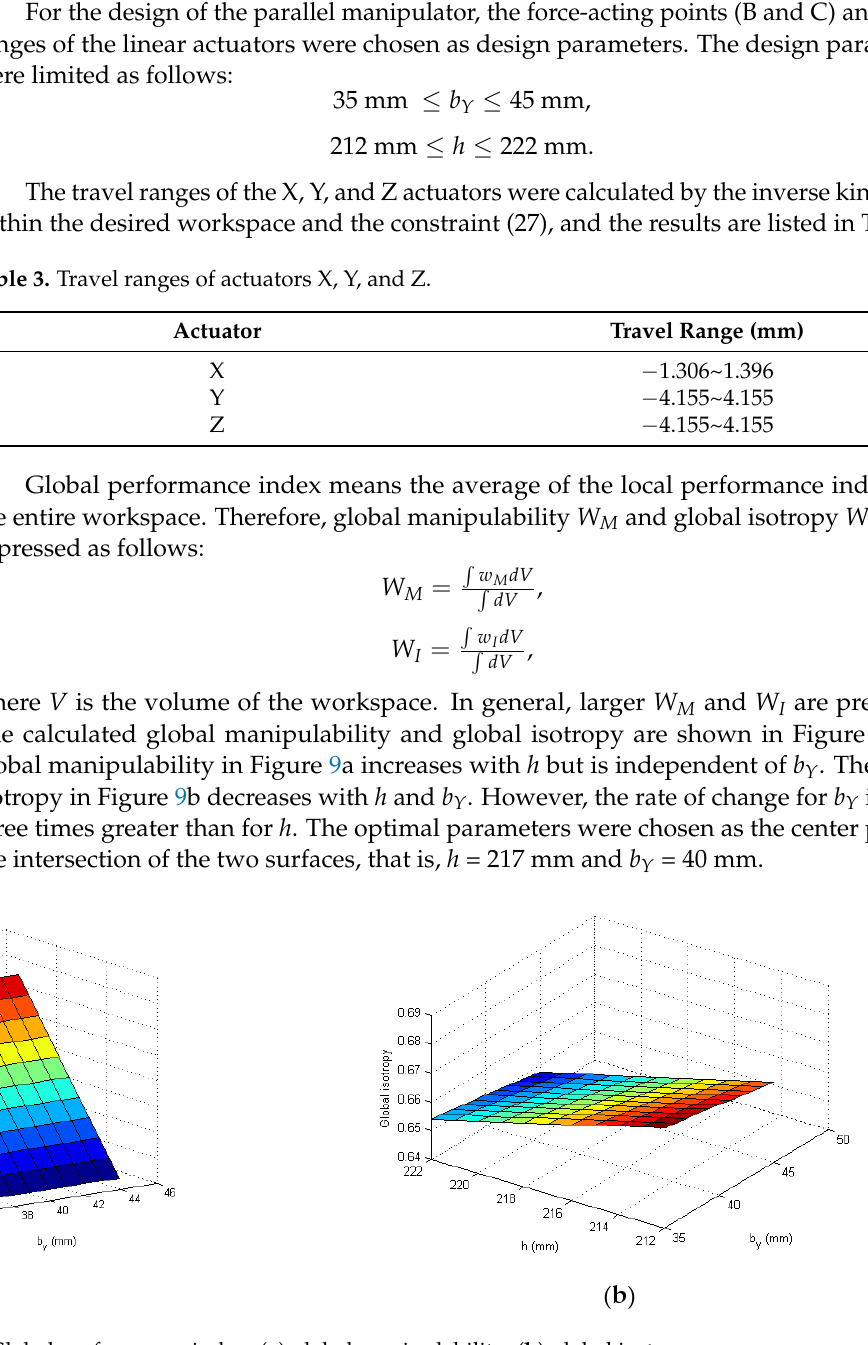
Table 3. Travel ranges of actuators X, Y, and Z.